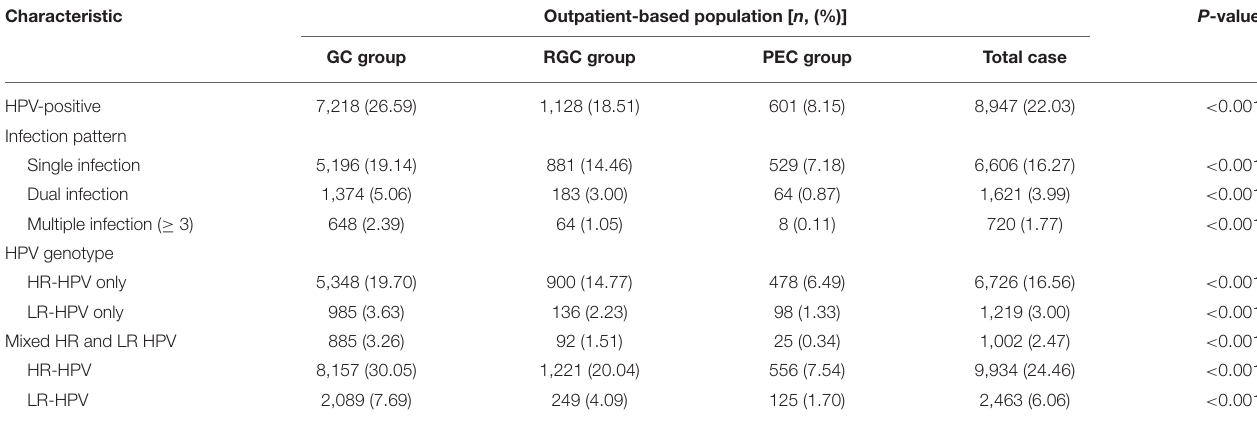
TABLE 1 | Prevalence of HPV infection among various outpatient-based